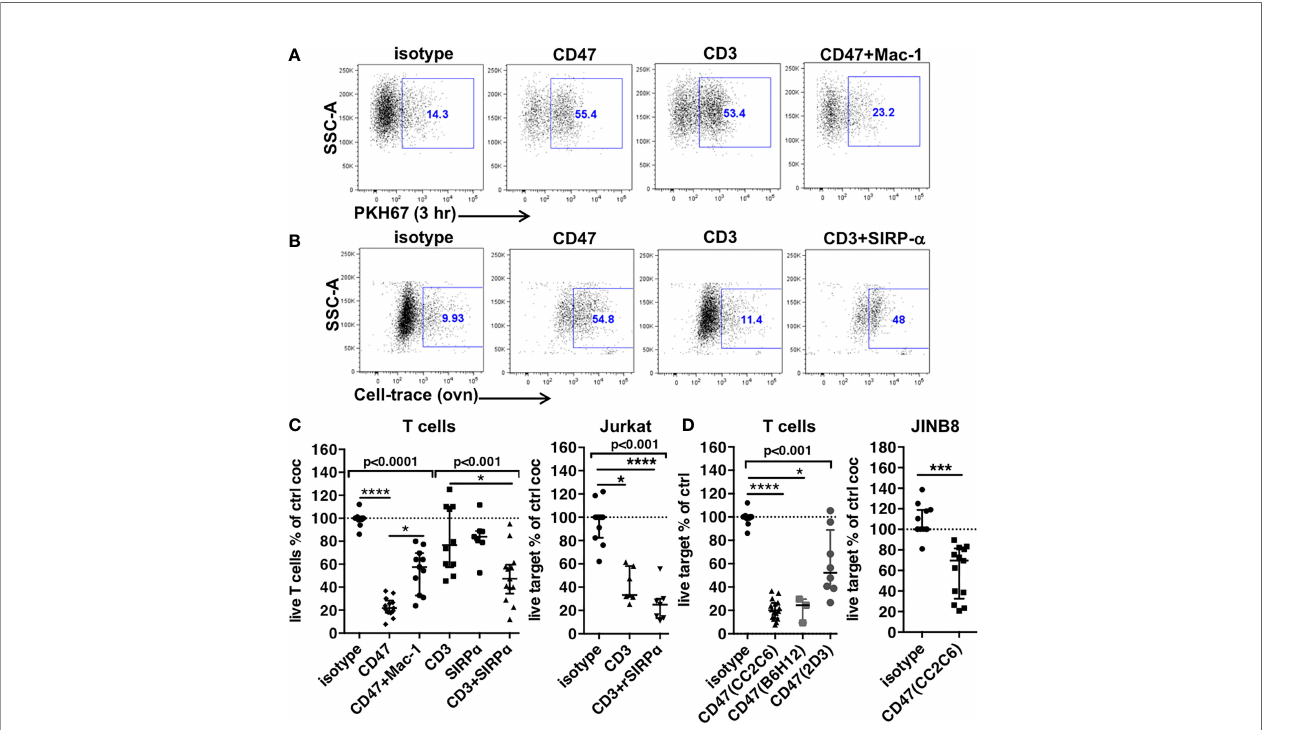
FIGURE 2 | Trogocytosis and cytotoxicity in PMNs ’ ADCC. (A) Expression of the PKH67 T cells membrane dye in PMNs after a 3-h coculture in the presence of indicated mAbs. (B) Uptake of Cell-Trace-stained T cells components in PMNs after overnight coculture in the presence of mAbs. For (A, B) , PMNs are gated after exclusion of doublets and dead cells. (C, D) Cytotoxicity of PMNs to targets indicated on top of graphs, evaluated by the percentages of live targets compared to control after overnight coculture. N = 6 – 12 different donors, ratios of PMNs to target = 1 – 3. CD3, anti-CD3 mAbs; CD47, anti-CD47 mAbs clone CC2C6, B6H12, or 2D3 as indicated; Mac-1, anti-CD11b+anti-CD18 mAbs. SIRP a , anti-SIRP a mAbs. rSIRP a , recombinant SIRP a protein. Median and IQR are shown. P -values from Kruskall – Wallis test indicated on top of groups, P -values from Dunn ’ s multiple comparison post-test on top of pairs: * P < 0.05; **** P < 0.001. For (D) , P -values from Wilcoxon matched pair test is